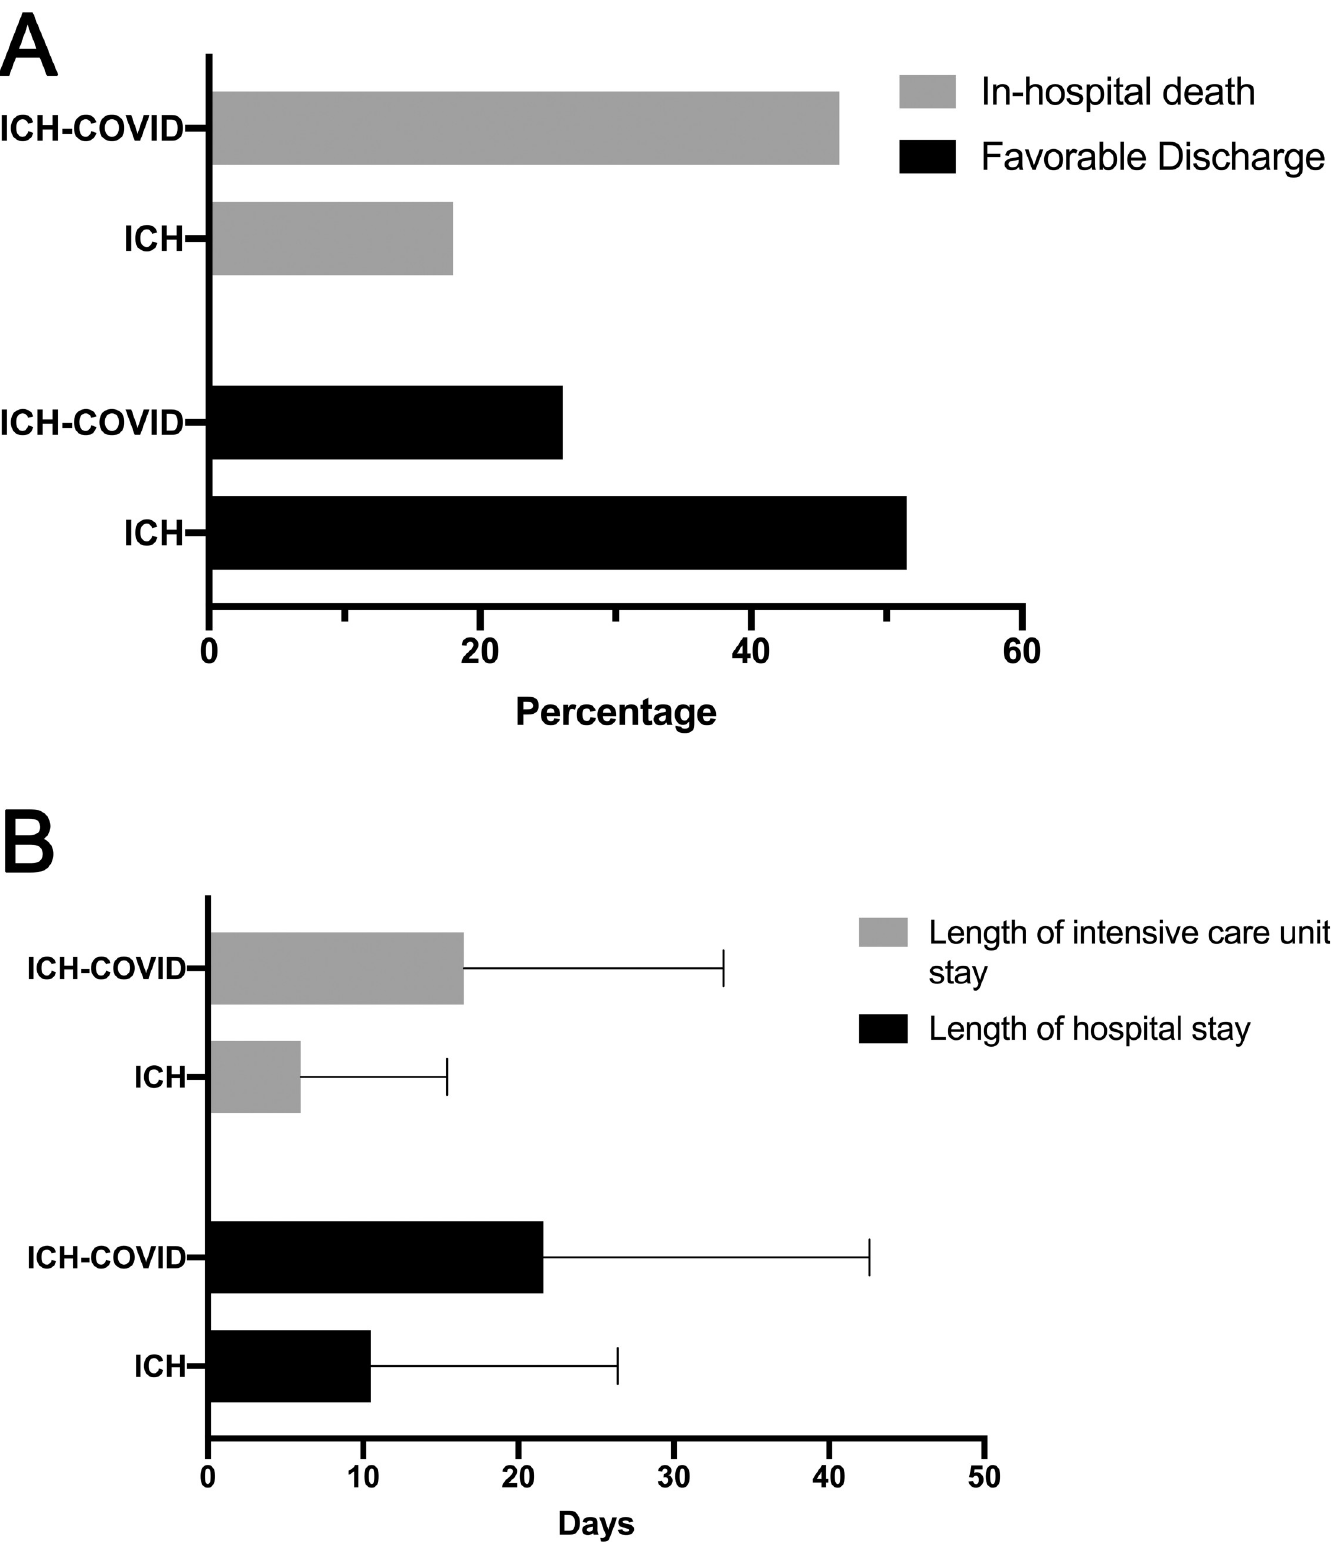
Fig 1. (A) Bar graph demonstrating rates of in-hospital death and favorable discharge among ICH-COVID and ICH cohorts. (B) Bar graph demonstrates rates of length of ICU and hospital stay among ICH-COVID and ICH cohorts.